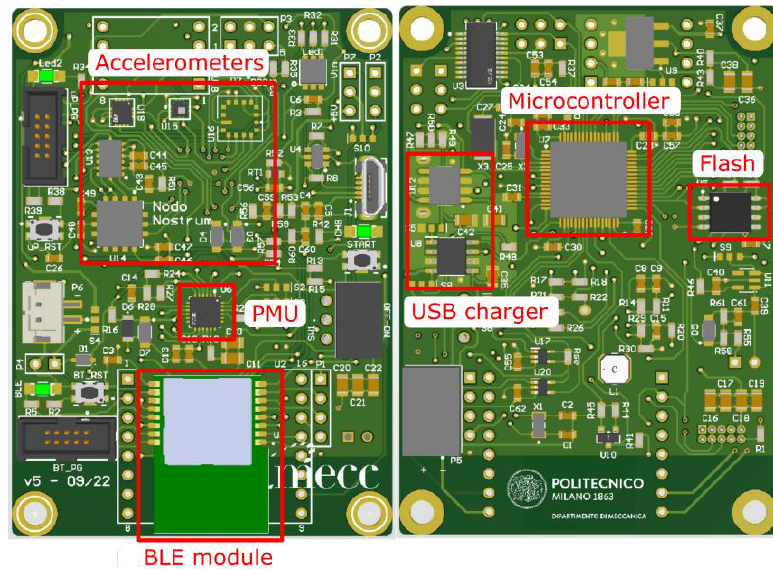
Figure 2. Layout of the PCB and focus on the main